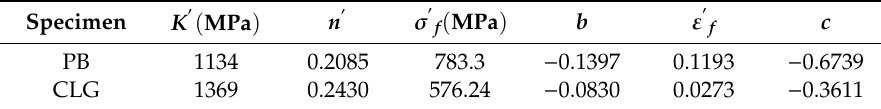
Table 3. Fatigue and cyclic stress–strain properties of welded structural details.